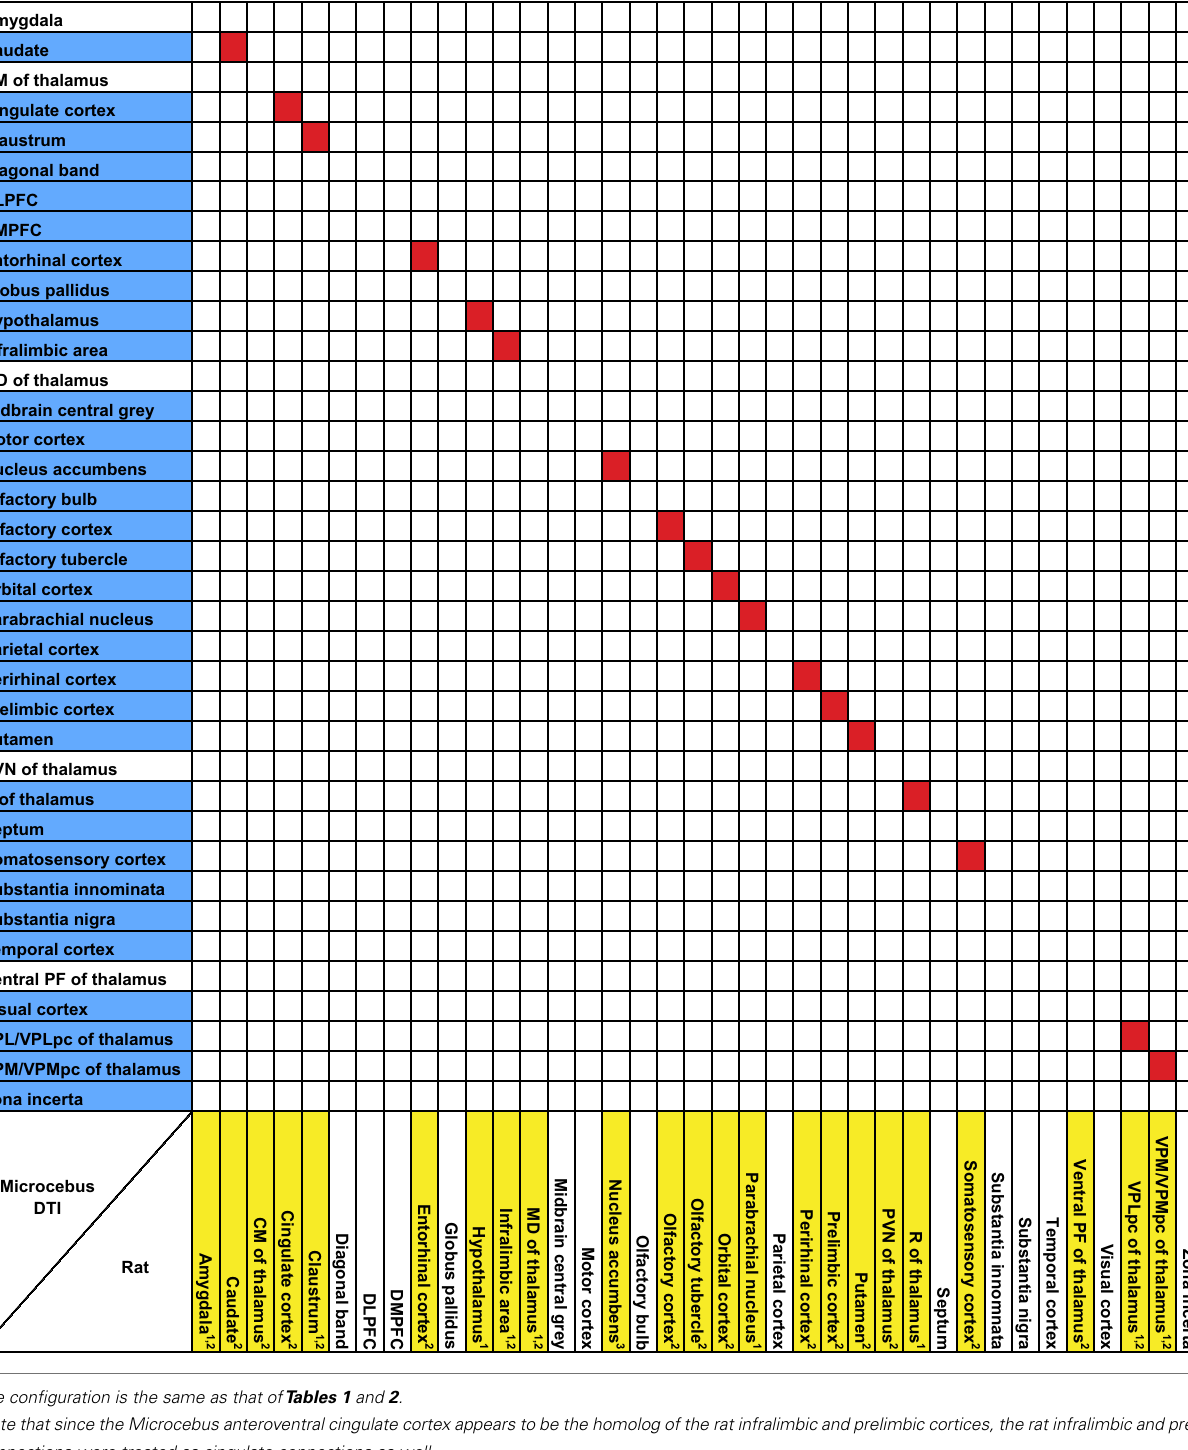
Table 3 | Comparison of insular connectivity in the rat and the Microcebus . Amygdala